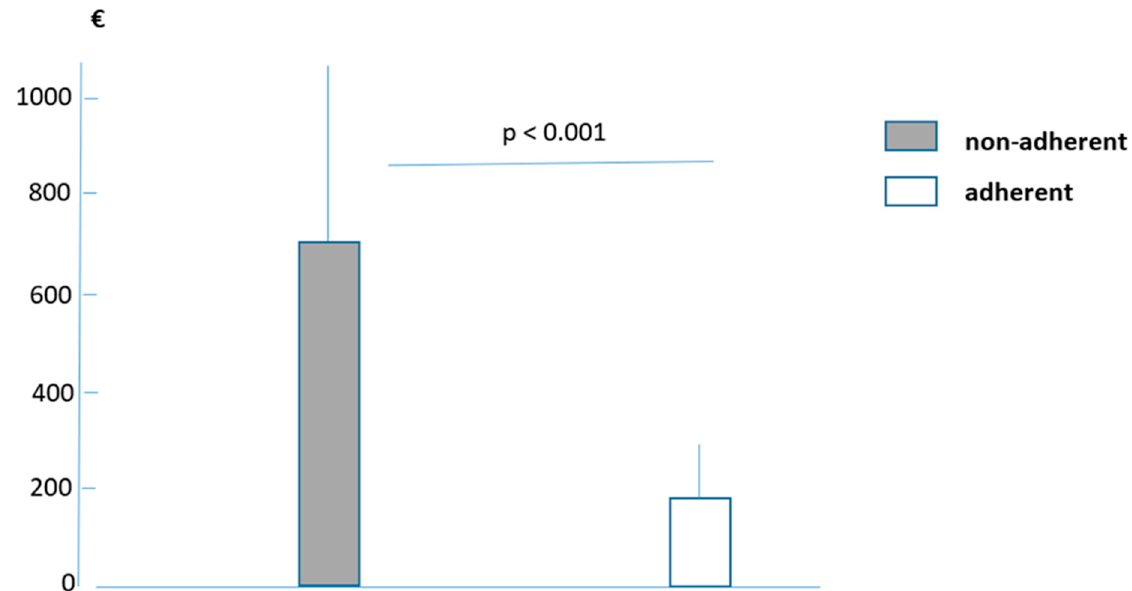
Figure 1. Mean cost (means ± SD) in Euros (€) over twelve months in non-adherent and adherent adolescents, and the corresponding statistical comparison (Wilcoxon test). (Cost of prescribed regular daily treatment not included.)